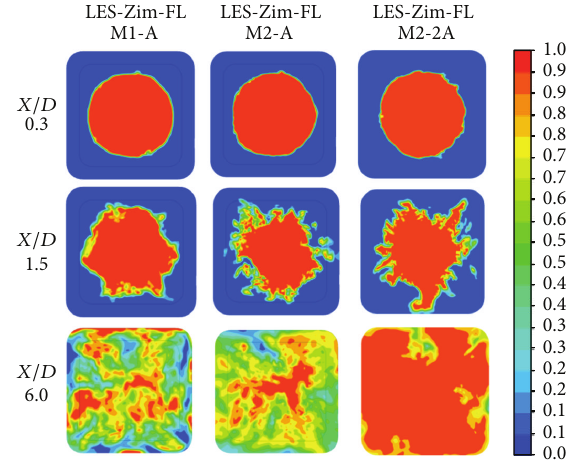
Figure 6: Instantaneous progress variable contours at three axial